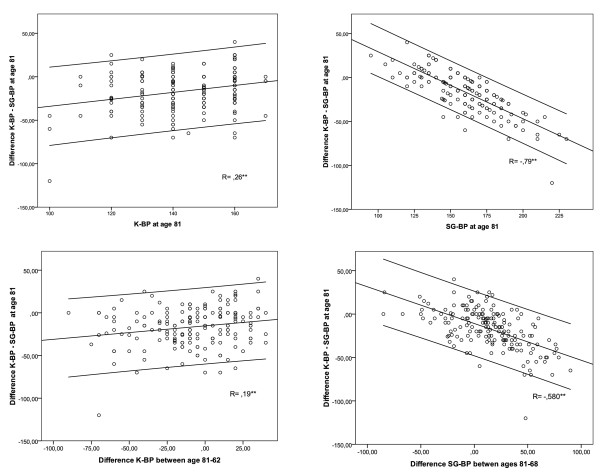
Correlation between the arithmetic difference Korotkoff - Strain Gauge blood pressure values (K-BP - SG-BP) at age 81 and individual blood pressure variables at age 81 (upper row), and blood pressure differences during follow-up period (bottom row).